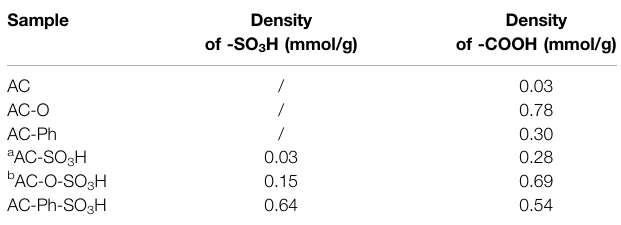
TABLE 2 | Surface -COOH and -SO 3 H contents of AC-Ph-SO 3 H and its precursors